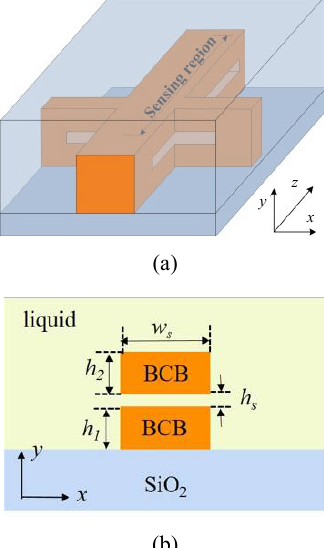
Fig. 1. 3-D view (a) and cross-sectional view (b) of the proposed polymer horizontal slot